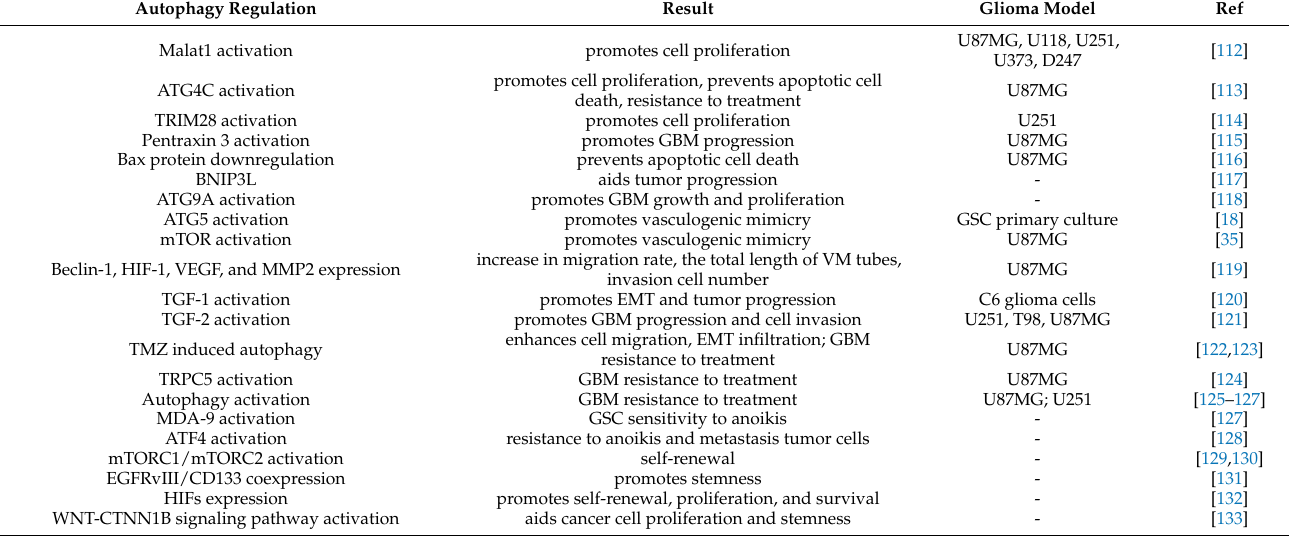
Table 3. Autophagy regulation promotes